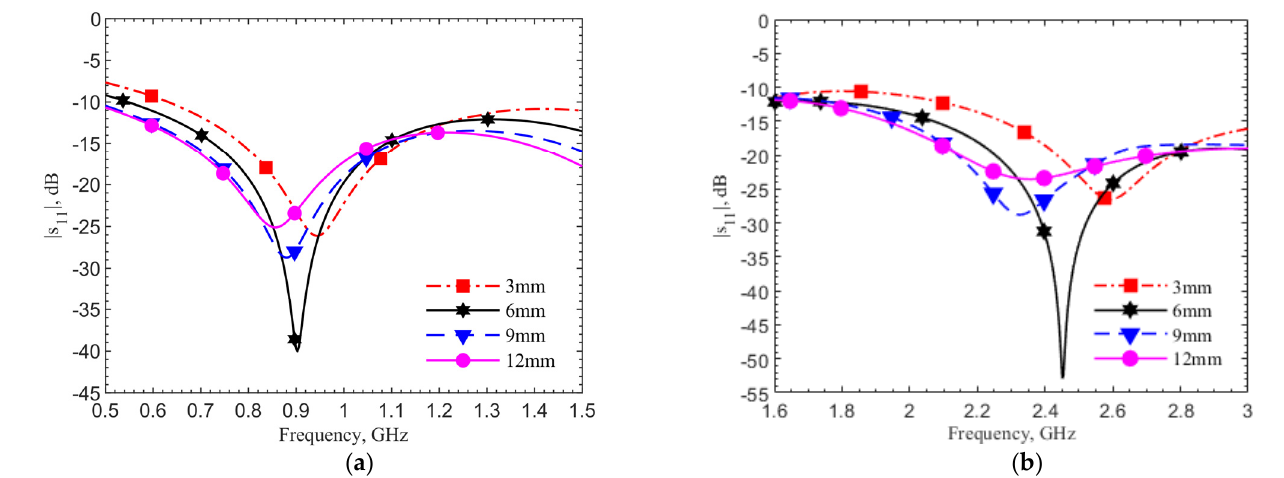
Figure 7. Simulations of the reflection coefficient for ( a ) the 903-MHz and ( b ) 2.45-GHz designs with tuning pad in the depths of 3, 6, 9 and 12 mm. The simulations are conducted with human skin properties, reprinted with permission from [29]. Copyright 1997 Institute of Applied